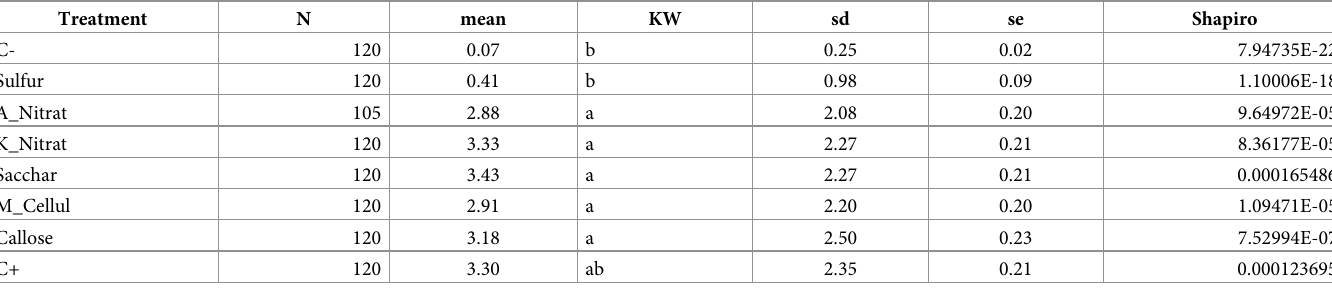
Table 1. Average seed number per fruit achieved during each treatment.